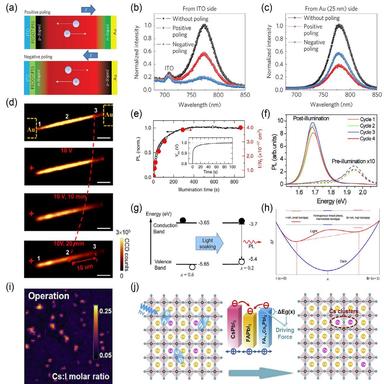
(a) Schematics of ion drift in perovskite during positive and negative poling, respectively. PL spectra from the perovskite layers close to either a PEDOT:PSS electrode (b) or an Au electrode (c) . Copyright 2015, Springer Nature Limited. (d) PL mapping images after different poling time. Scale bars: 5 lm. Copyright 2016, American Chemical Society. (e) The PL over time under initial illumination. Inset: VOC rise of a full solar cell under 1-sun illumination. Copyright 2016, Sprin